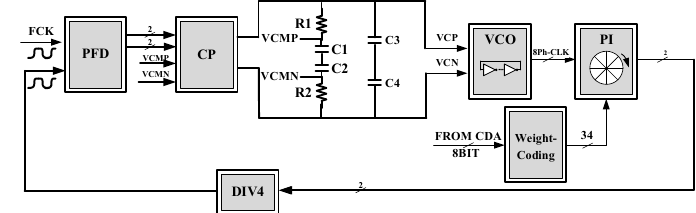
Figure 10. Architecture and design of